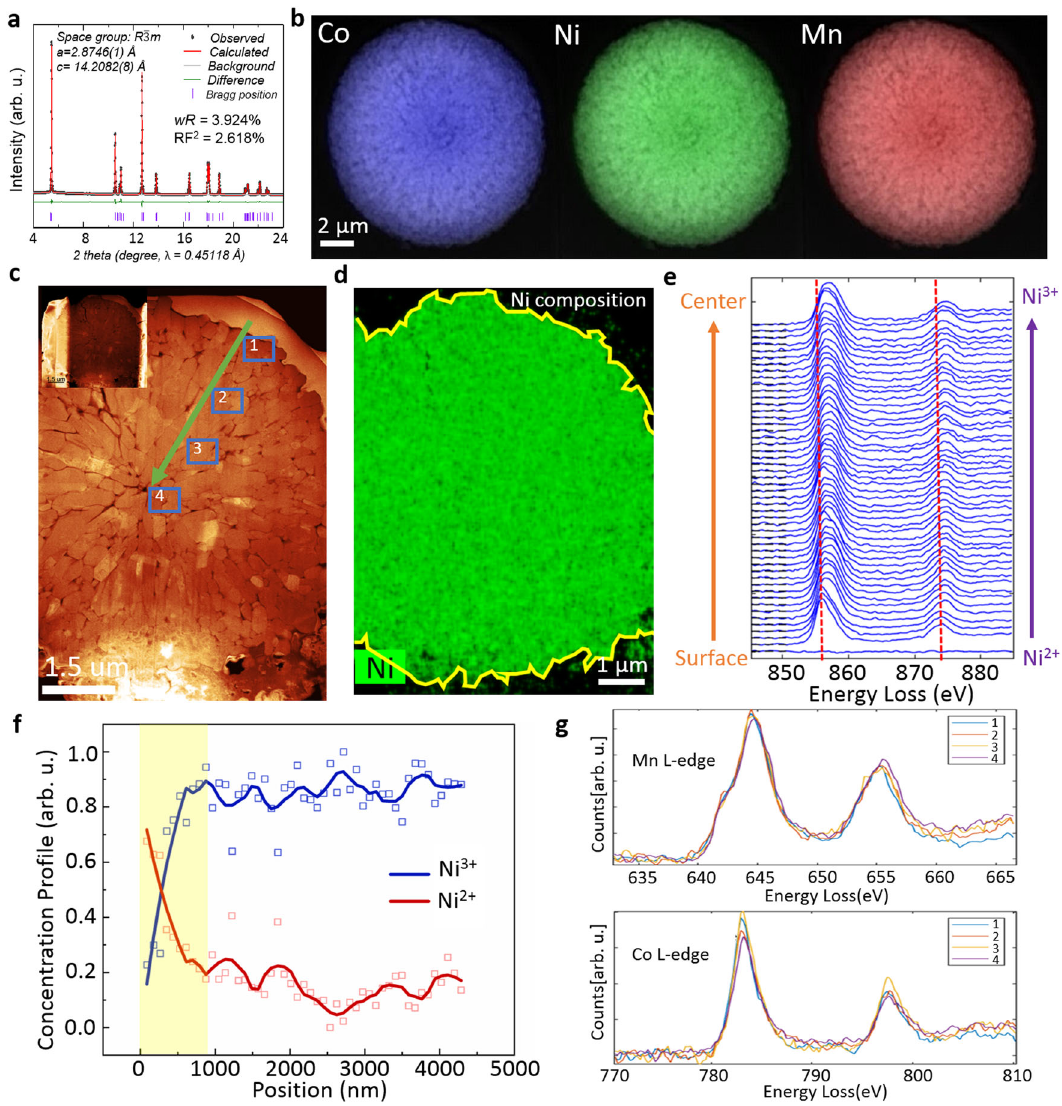
Fig. 1 Structural and chemical characterization of the pristine valence gradient NMC811 material (VG-NMC811). a Rietveld re fi nement of pristine VG- NMC811. b X-ray fl uorescence quantitative mapping of Ni, Mn, and Co showing uniform transition metal distribution across the whole secondary particle. c High-angle annular dark- fi eld (HAADF) scanning transmission electron microscopy (STEM) images of a cross-sectional slice of VG-NMC811